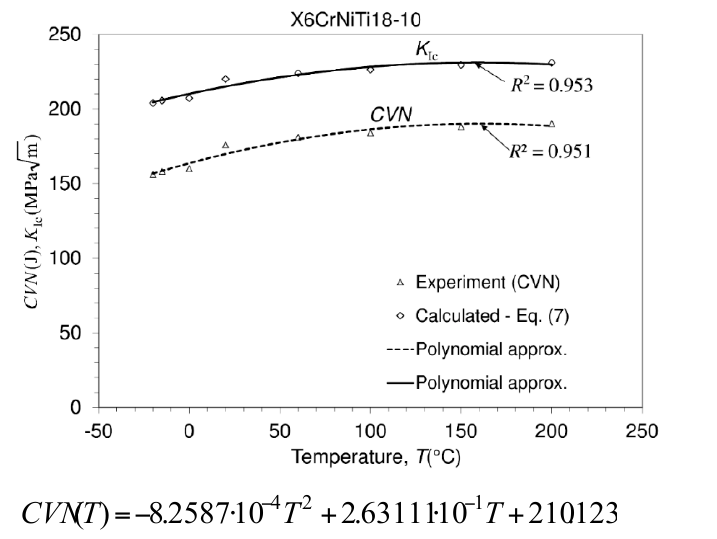
Figure 10. Charpy V-notch specimen and impact energy determination. ( a ) Specimen’s geometry- Charpy V-notch impact energy determination; ( b ) Charpy V-notch energy (CVN); and calculated fracture toughness ( K Ic ) versus temperature.